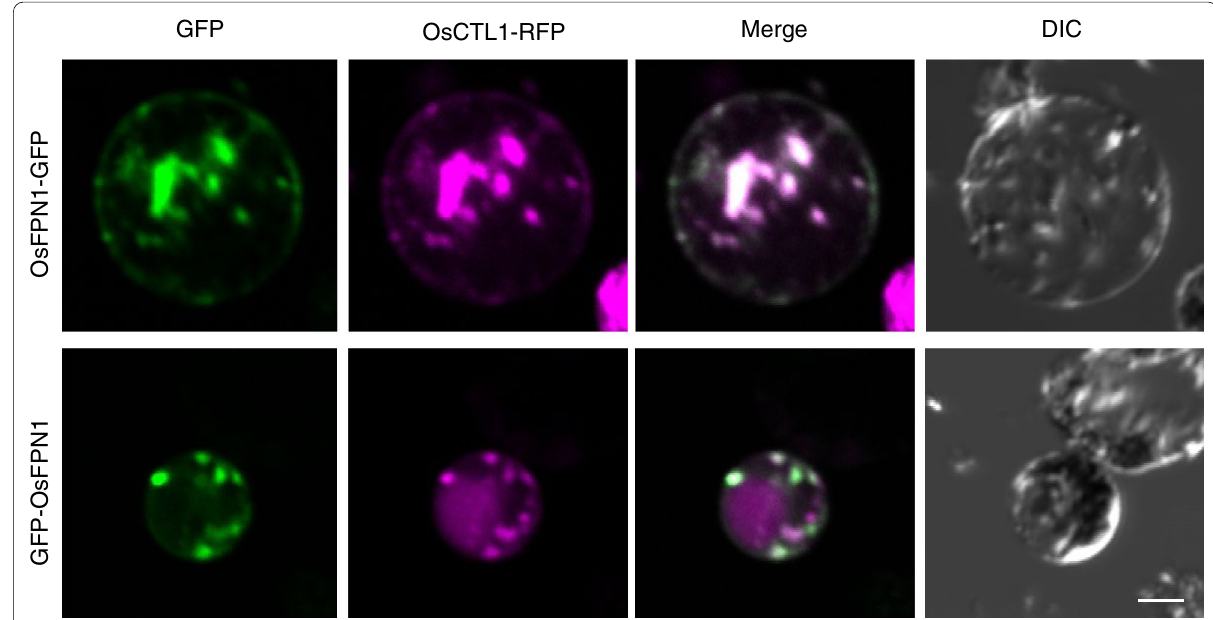
Fig. 5 Subcellular localization of OsFPN1. Transient expression of OsFPN1-GFP and GFP-OsFPN1 in protoplasts prepared from 10-d-old rice leaf sheaths. OsCTL1-RFP was used as the Golgi marker. Bar